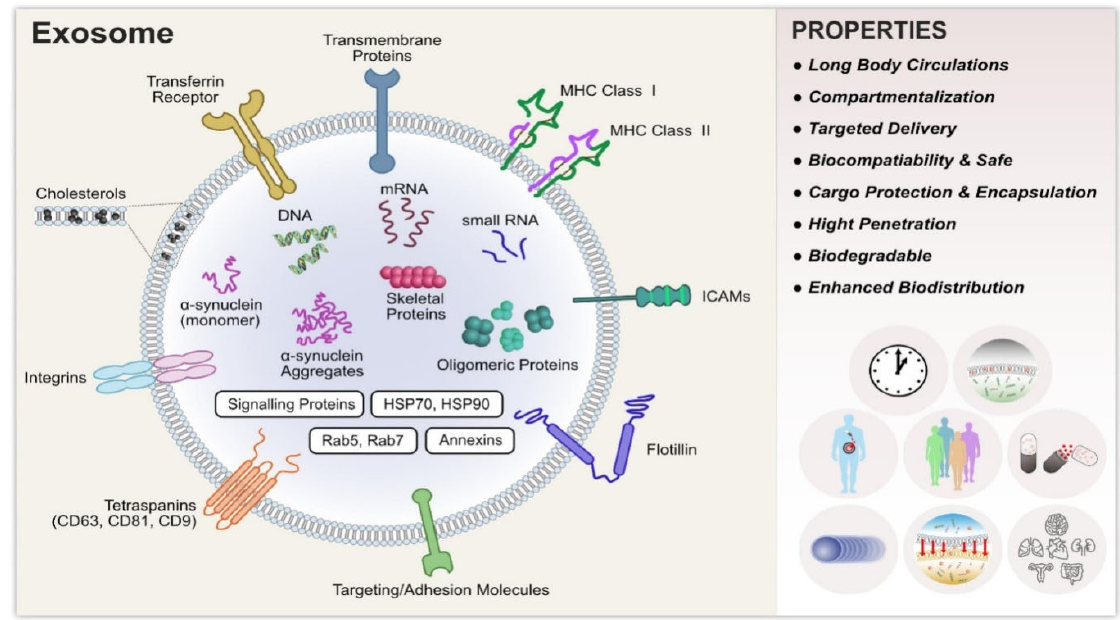
Figure 1. Typical structure of exosomes, properties, and functional attribution of various biomolecules present in exosomes. Adopted with kind permission from reference [35].